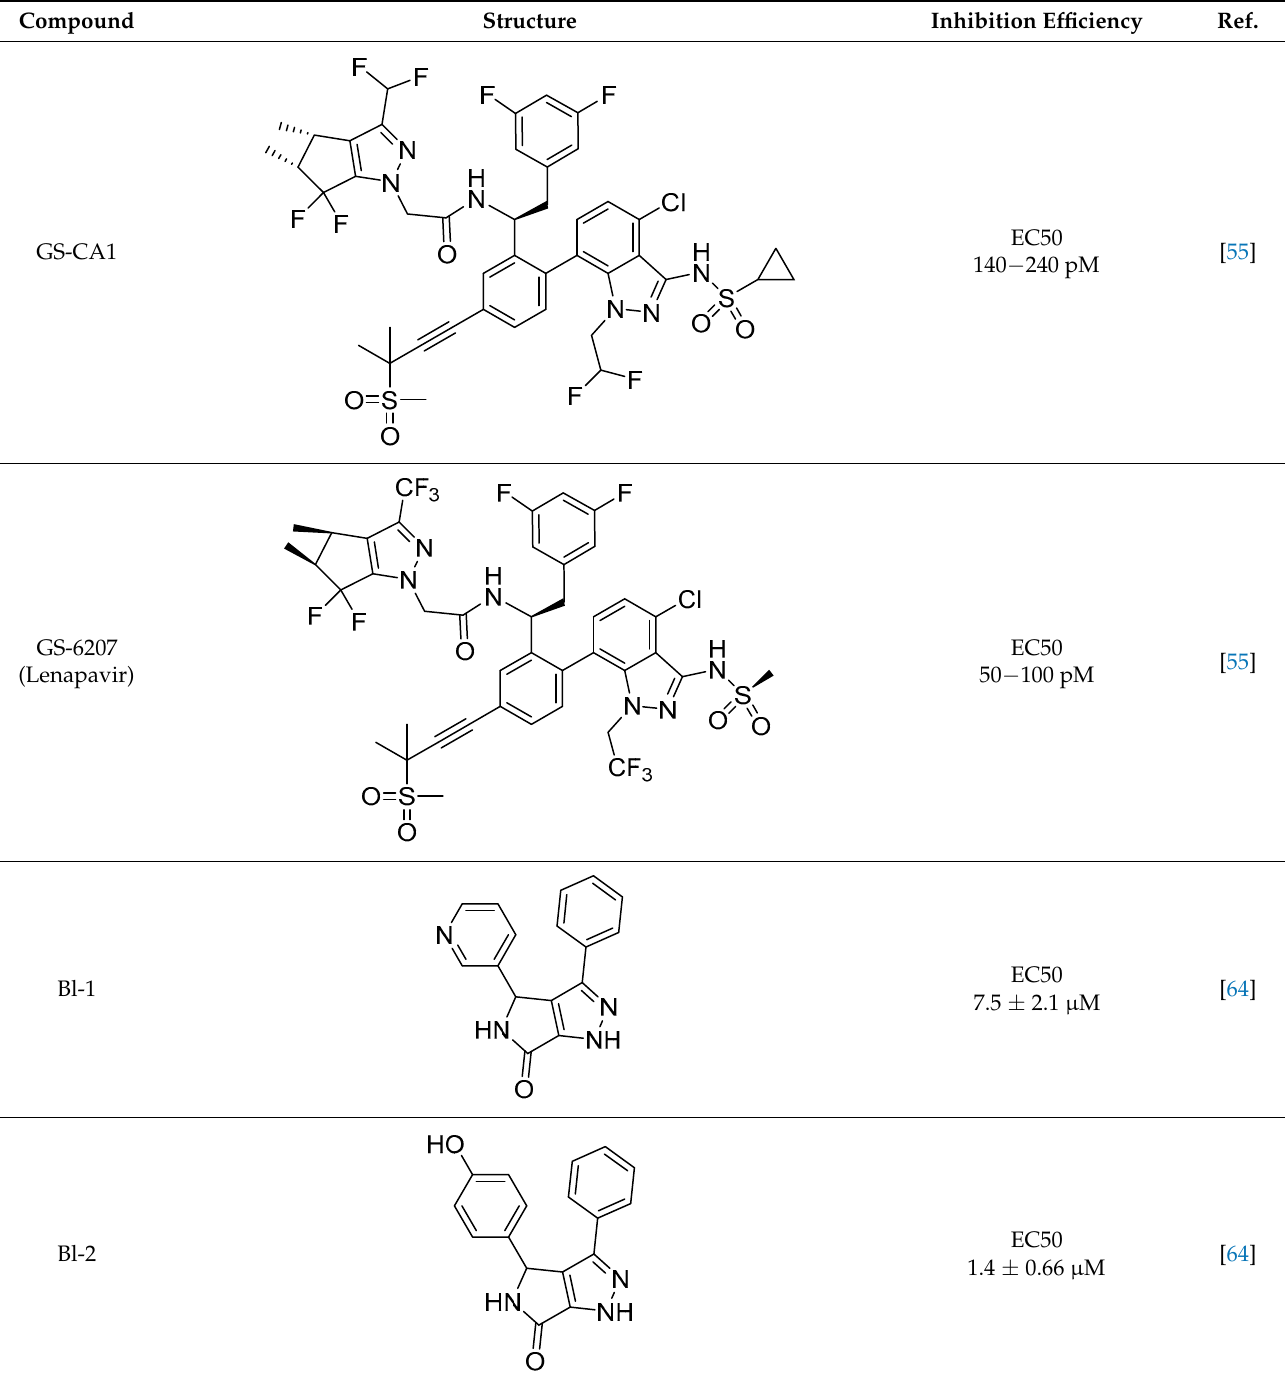
Table 1. Cont. Compound Structure Inhibition Efficiency